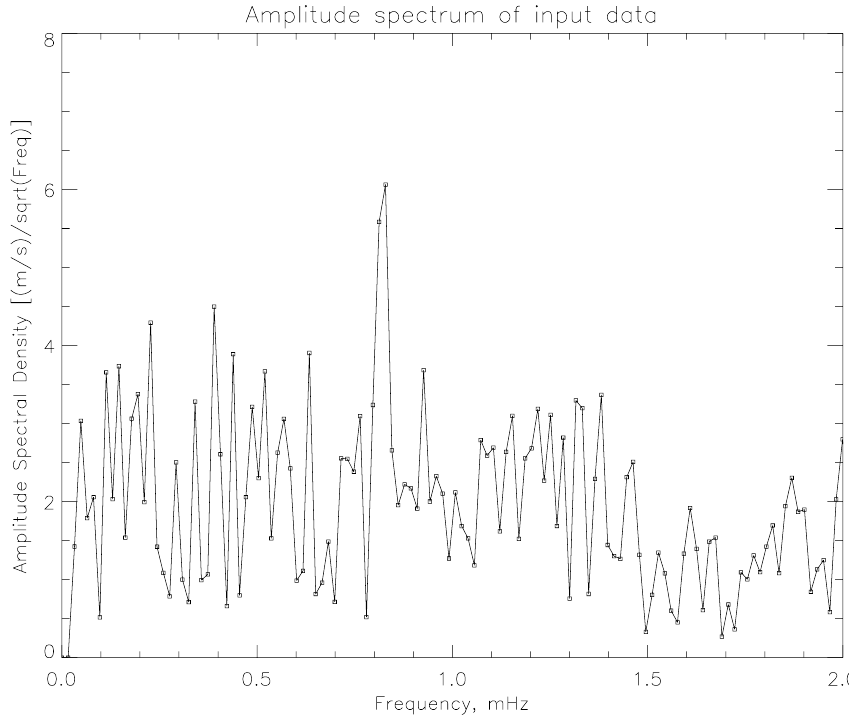
Fig. 5. Amplitude spectrum of FPS λ 630 nm wind data from the night of DoY